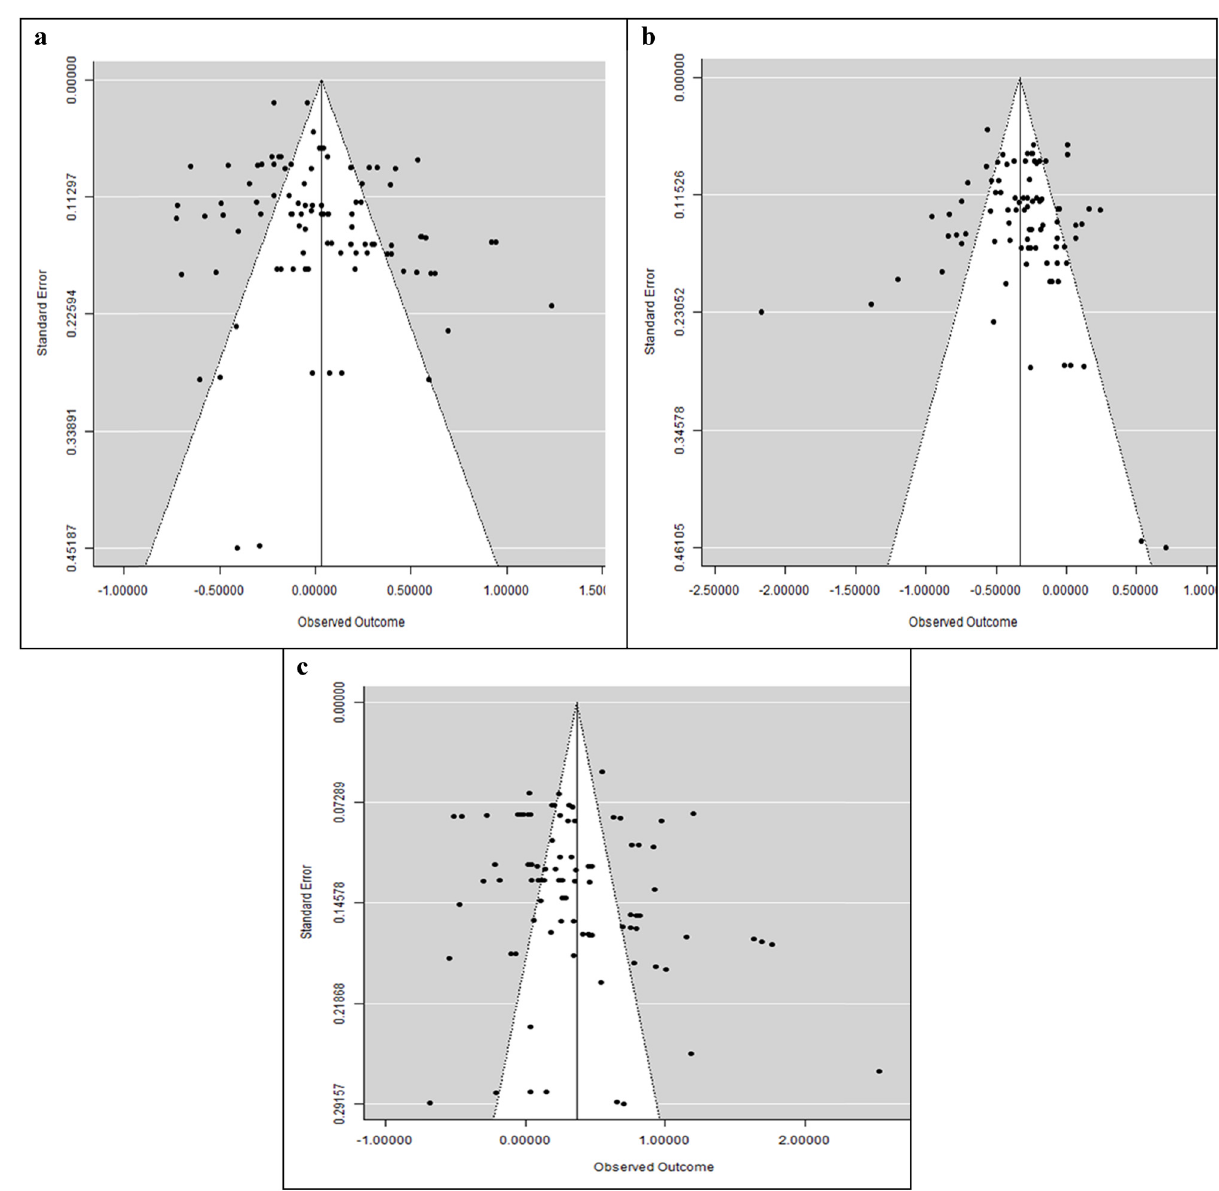
Figure 6: Funnel graphs of the e ff ect of dietary Bacillus supplementation on ( a ) feed intake; ( b ) FCE; and ( c ) ADG in broiler